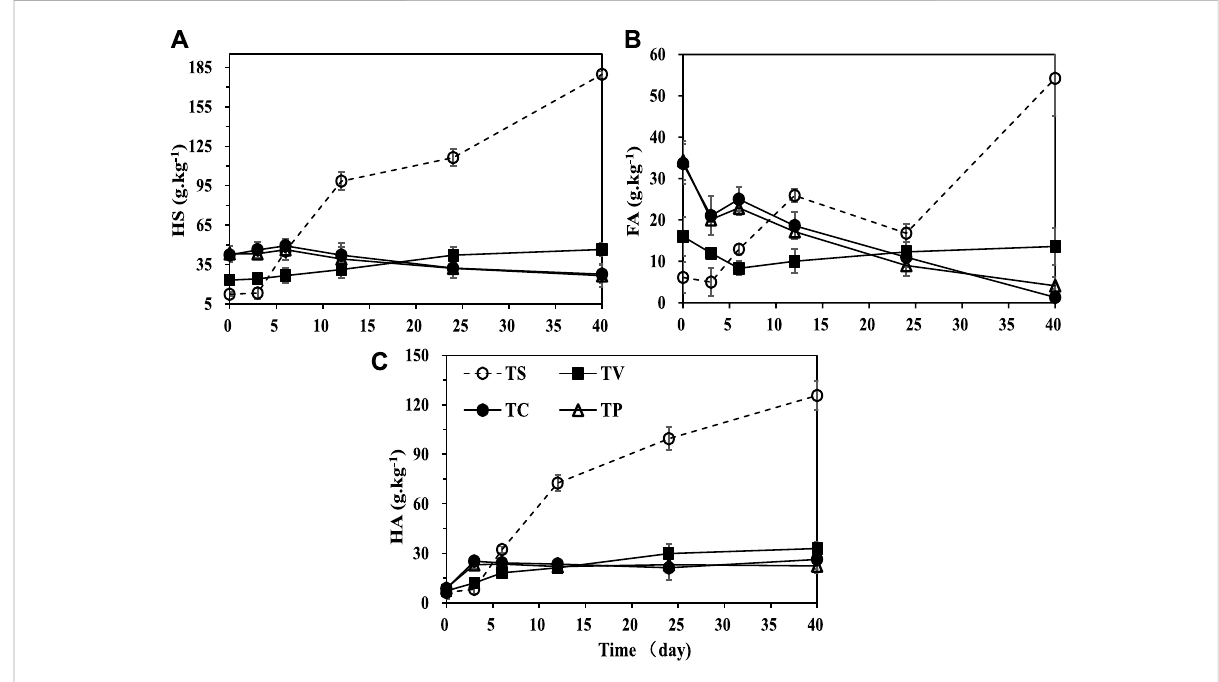
FIGURE 6 Changes in (A) humus, (B) fulvic acid, and (C) humic acid of composting in a single